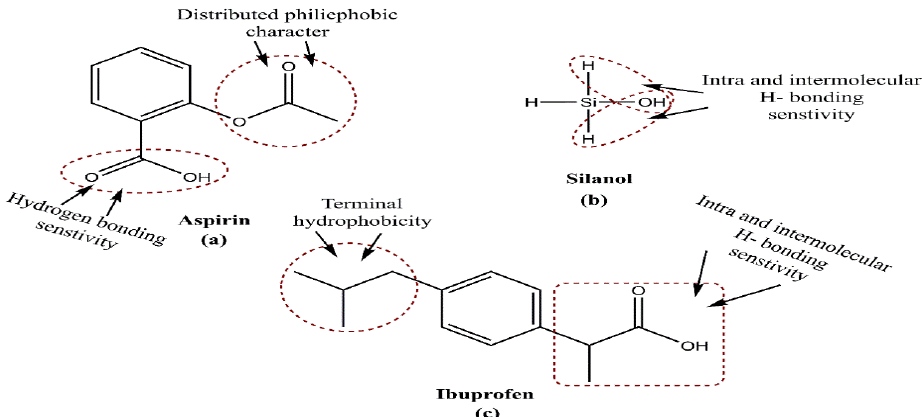
Figure 6. Chemical structures of aspirin, silanol and ibuprofen; the –NH 2 functionalization of silanol could bind aspirin and ibuprofen more strongly than non-functionalized. This could be a reason for their steady release when delivered with –NH 2 -functionalized